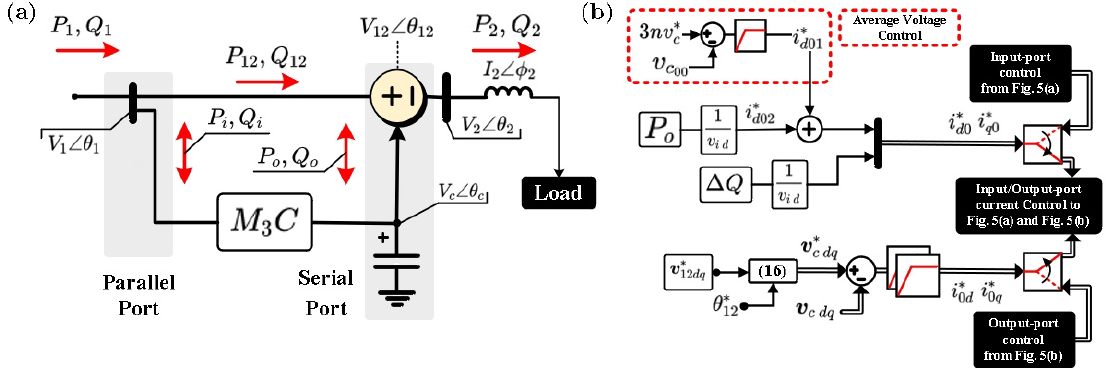
Figure 8. ( a ) Detailed proposed M 3 C -UPFC topology. ( b ) Proposed M 3 C -UPFC control